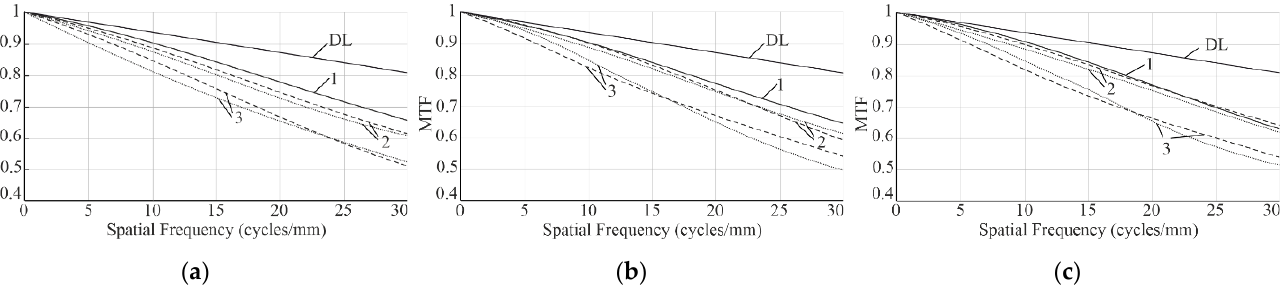
Figure 6. Polychromatic diffraction modulation transfer function (MTF) for the refractive version of the objective: ( a ), at − 40 °C; ( b ), at 20 °C; ( c ), at +60 °C. Curved lines DL, Diffraction Limit; 1, at 0°; 2, at 5° half-field angle; and 3, at 9.75° half-field angle (short-dashed curves, sagittal, and long-dashed curves, tangential responses).